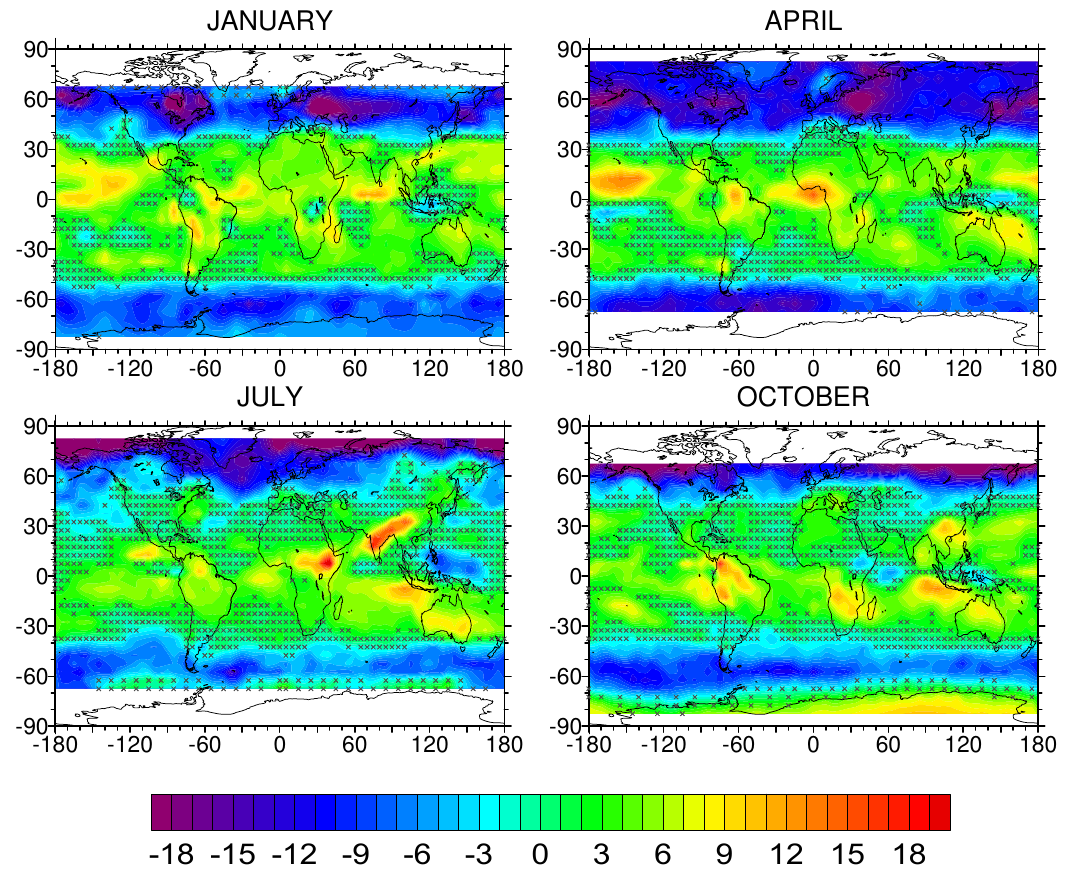
Figure 4: Multi model mean changes (%) in UV-Ery under all-sky conditions. Changes are given for monthly means averaged over the period 2090–2099 relative to 1960–1969, reflecting the effect of climate change on UV. Crosses mark areas where changes are not statistically significant at the 95% level.